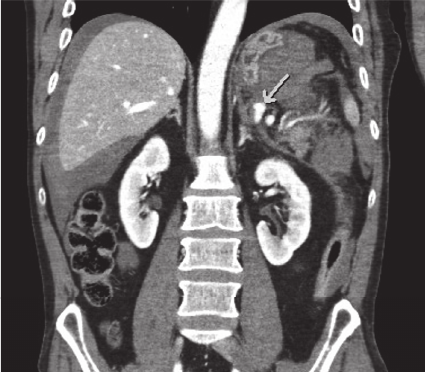
Figure 2: 9 mm contrast-filled dilatation of splenic artery (arrow) on initial CT.